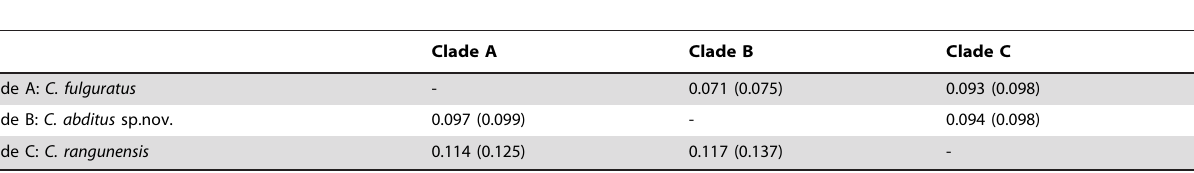
Table 5. Ranges of genetic divergence of three Cyclophorus fulguratus clades and related species based on 16S rRNA gene (above diagonal) and COI gene (below